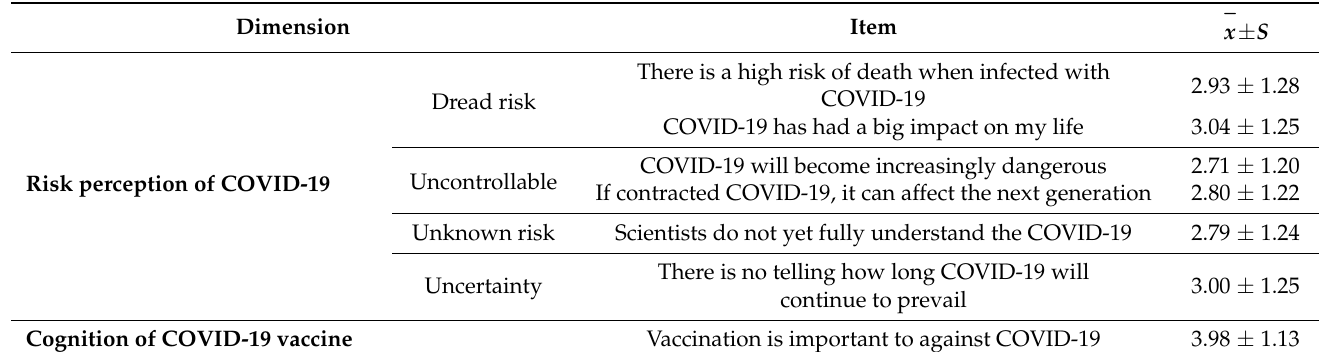
Table 1. Individual beliefs of